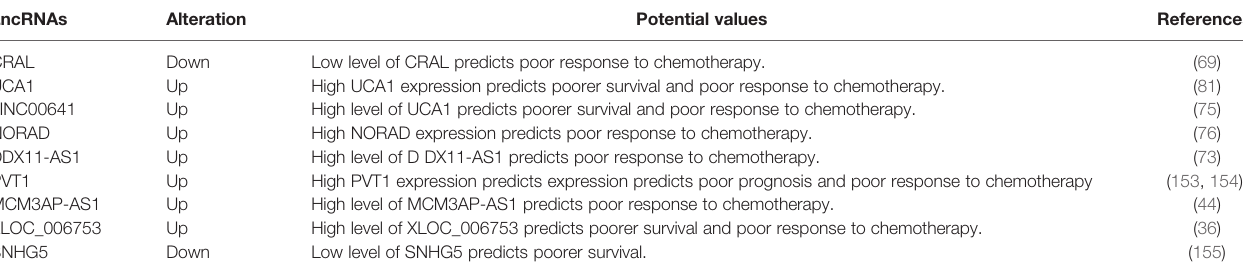
TABLE 2 | Drug resistance-related lncRNAs as diagnostic and prognostic biomarkers in GC.